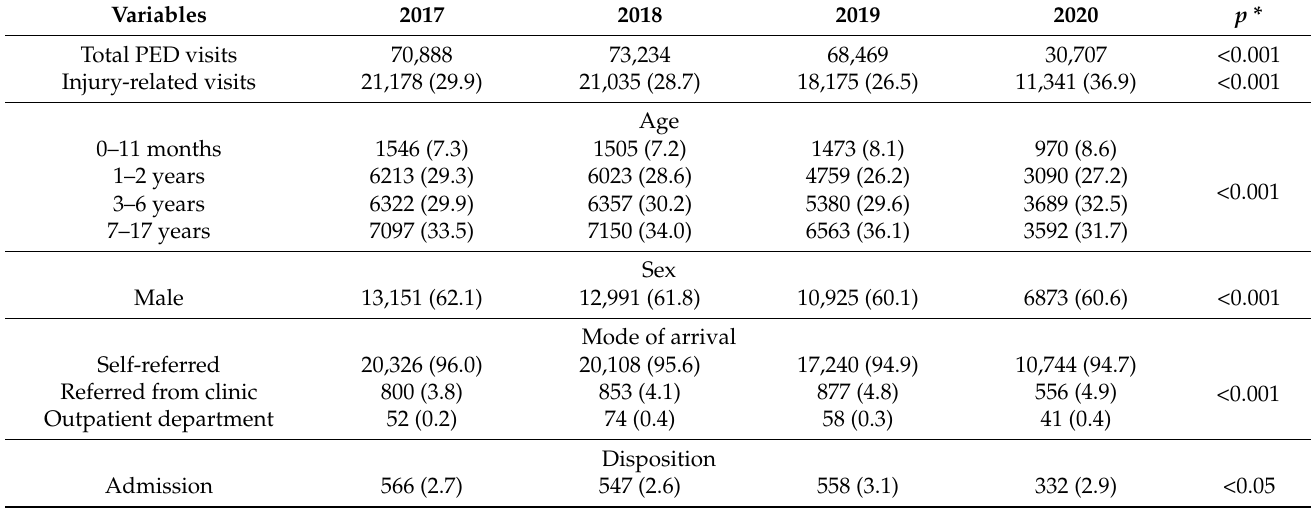
Table 2. Characteristics of Patients with injuries in the Pediatric Emergency Department, N (%).